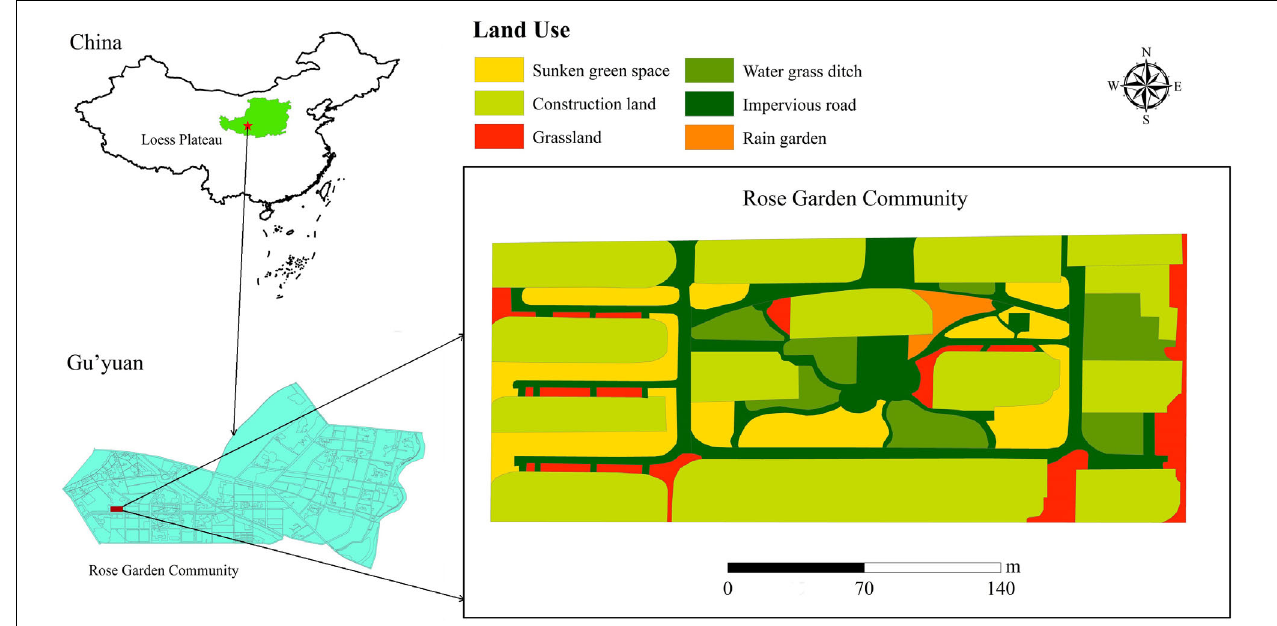
FIGURE 1 | Location of the study area.